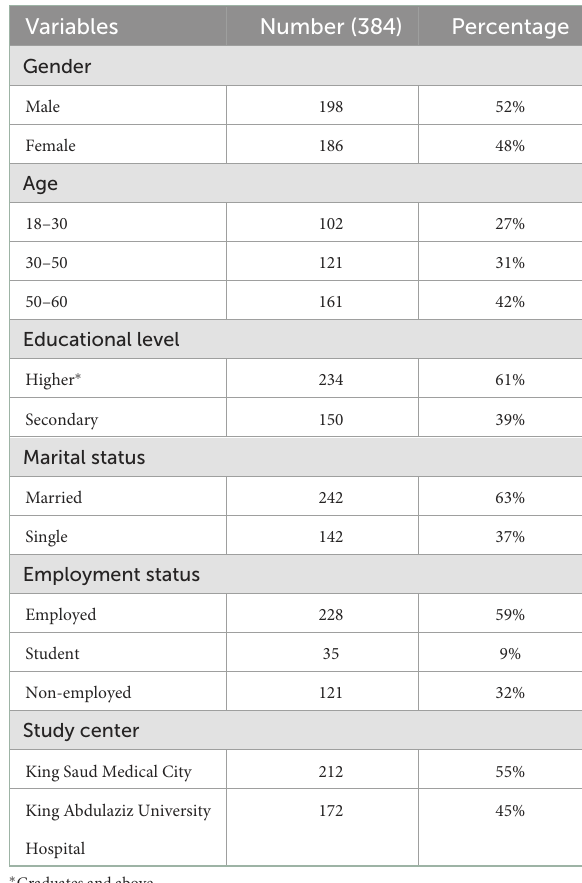
TABLE 1 Sociodemographic features of the